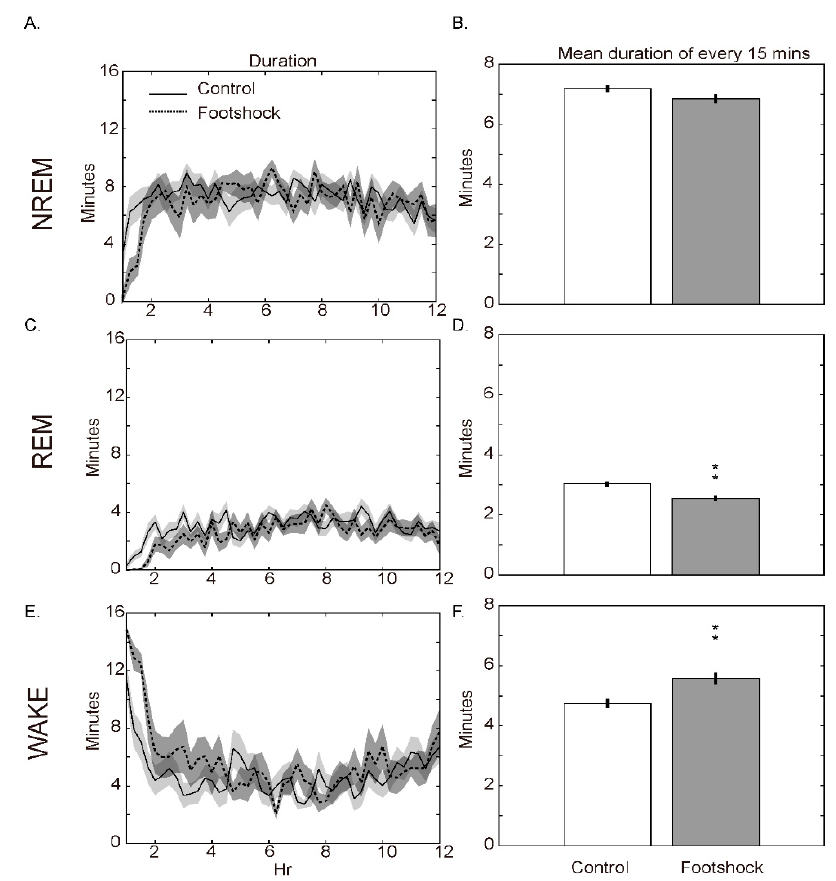
Figure 1. Comparison of the duration between distinct vigilance stages. ( A ) NREM sleep duration. The solid line and light gray shadow represent the values of means ± SEMs, for every 15 min during the light period in the control group. The dashed line and dark gray shadow are the values acquired from the footshock group. ( B ) Mean duration of 15 min bins across the total 12 h light period. The white bar is the value of mean ± SEM obtained from the control grou,p and the gray bar represents data acquired from the footshock group. ( C , D ) Represented the data from REM sleep. ( E , F ) Demonstrated the result of wakefulness. ** Indicates the difference reaches statistical significance of p < 0.01.